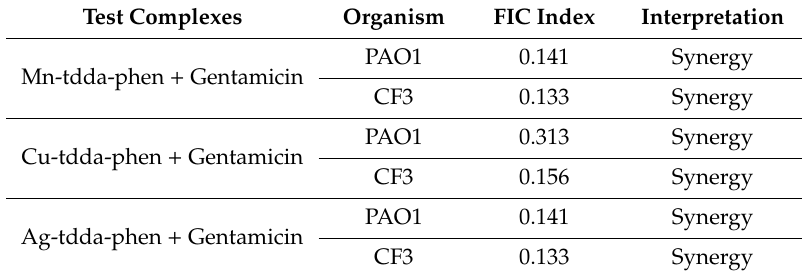
Table 2. Results of interaction studies for metal-tdda-phen / gentamicin combinations against PAO1 (reference strain) and CF3 (clinical isolate) in established